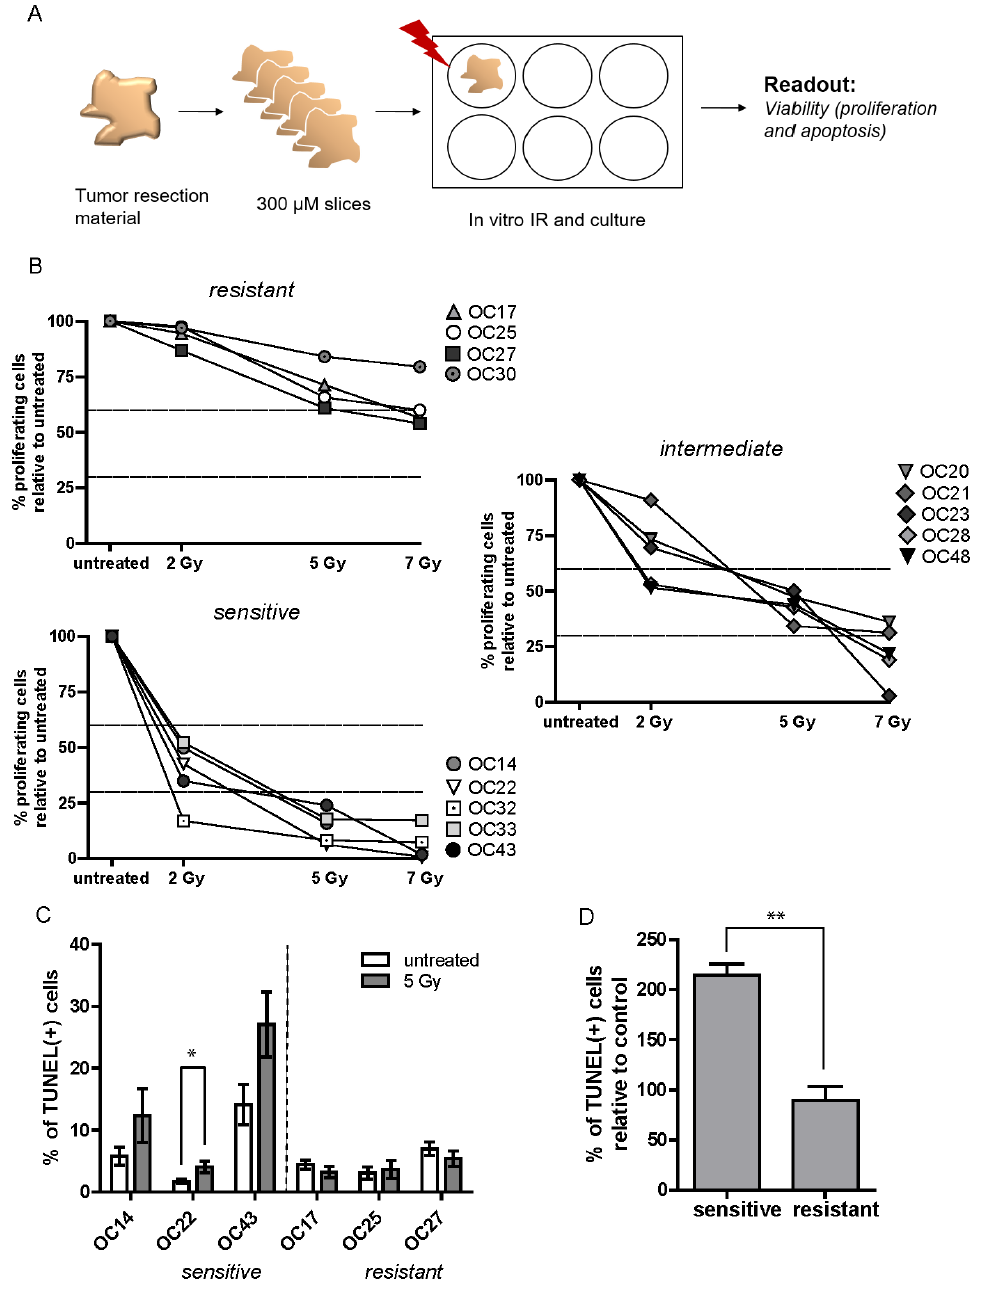
Figure 3. HNSCC tumor samples display heterogeneity in response to IR. ( A ) Schematic representation of the experimental setup. ( B ) changes in % of EdU cells, relative to untreated control, in the resistant, intermediate and sensitive group of samples. Each point represents the mean of ≥4 FoV per sample, and for clarity no SEM is displayed. Dashed lines mark 30% and 60% of the proliferation of untreated control. ( C ) Change in % of TUNEL positive cells upon five days of culture. Each graph bar represents the mean of ≥4 FoV and error bars represent SEM. ( D ) Difference in % of TUNEL positive cells between the resistant and sensitive group relative to untreated control. Graph bars represent the mean of three samples and error bars represent SEM. A t-test was used to determine significance. * p < 0.05, ** p < 0.01.